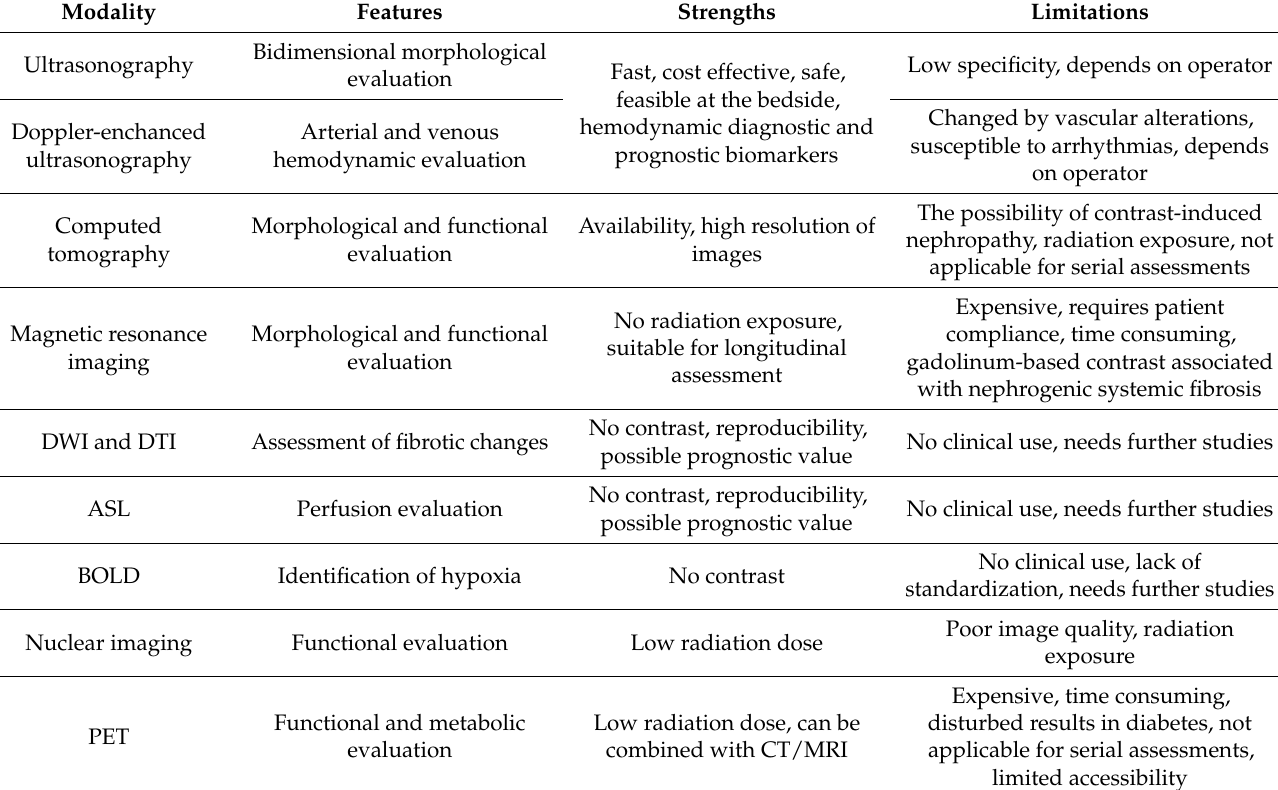
Table 4. Comparison of renal imaging